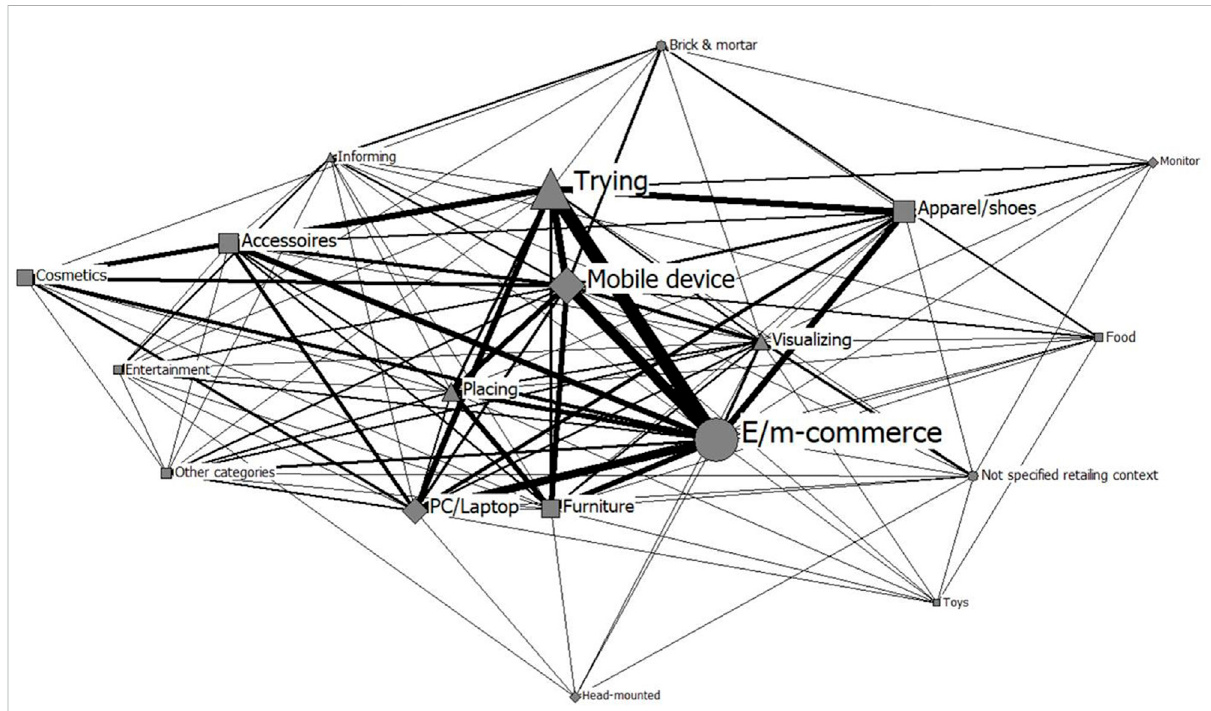
FIGURE 1 NetworkanalysisoftheAR-relatedfactorsstudiedinpreviousresearch.Notes. C Typeofretailing, ■ productcategory, ▲ ARfunction, ◆